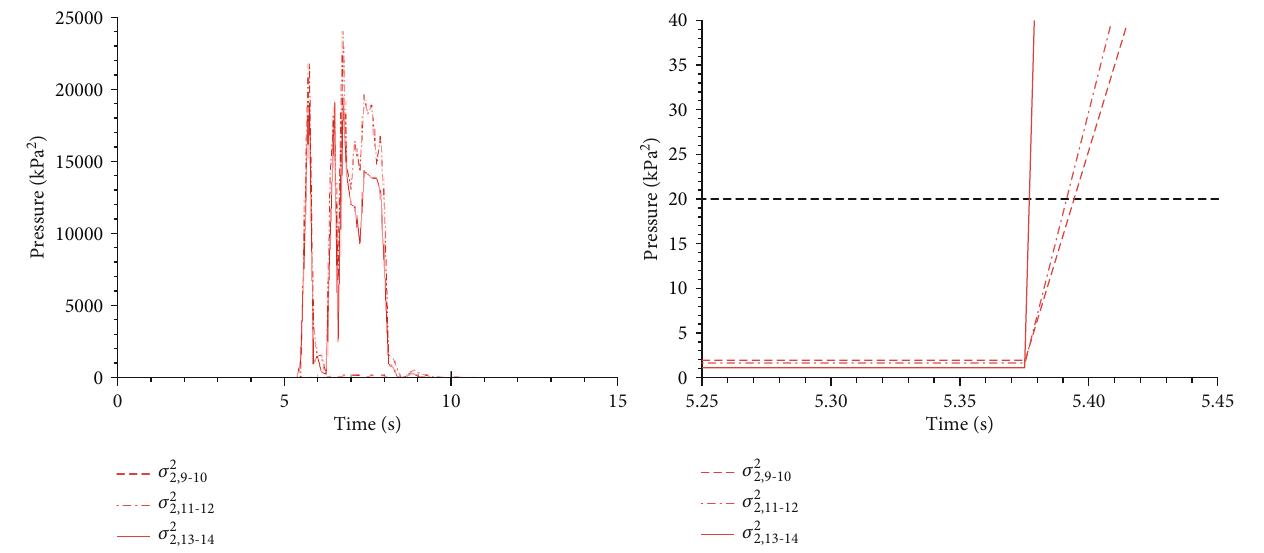
Figure 19: Variation of σ 2 2 at R2 inlet, S2 outlet, and compressor